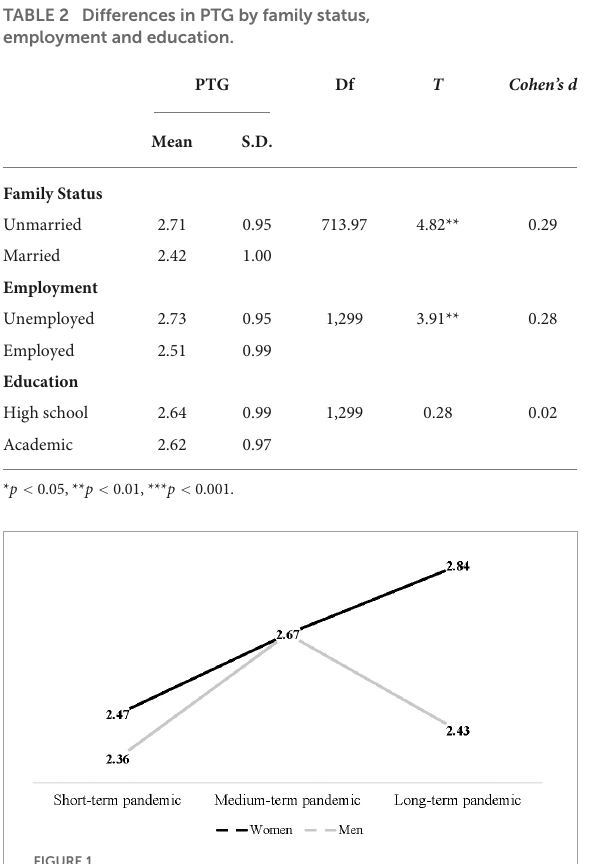
FIGURE1 Interaction between gender and pandemic